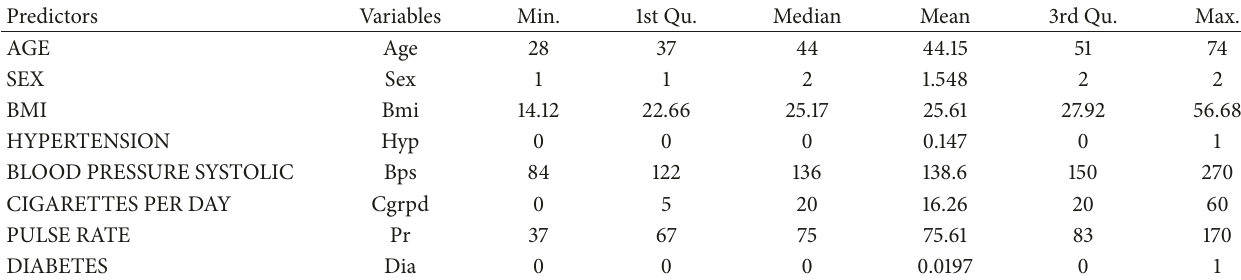
Table 3: Summary statistics for risk factors used in risk model.